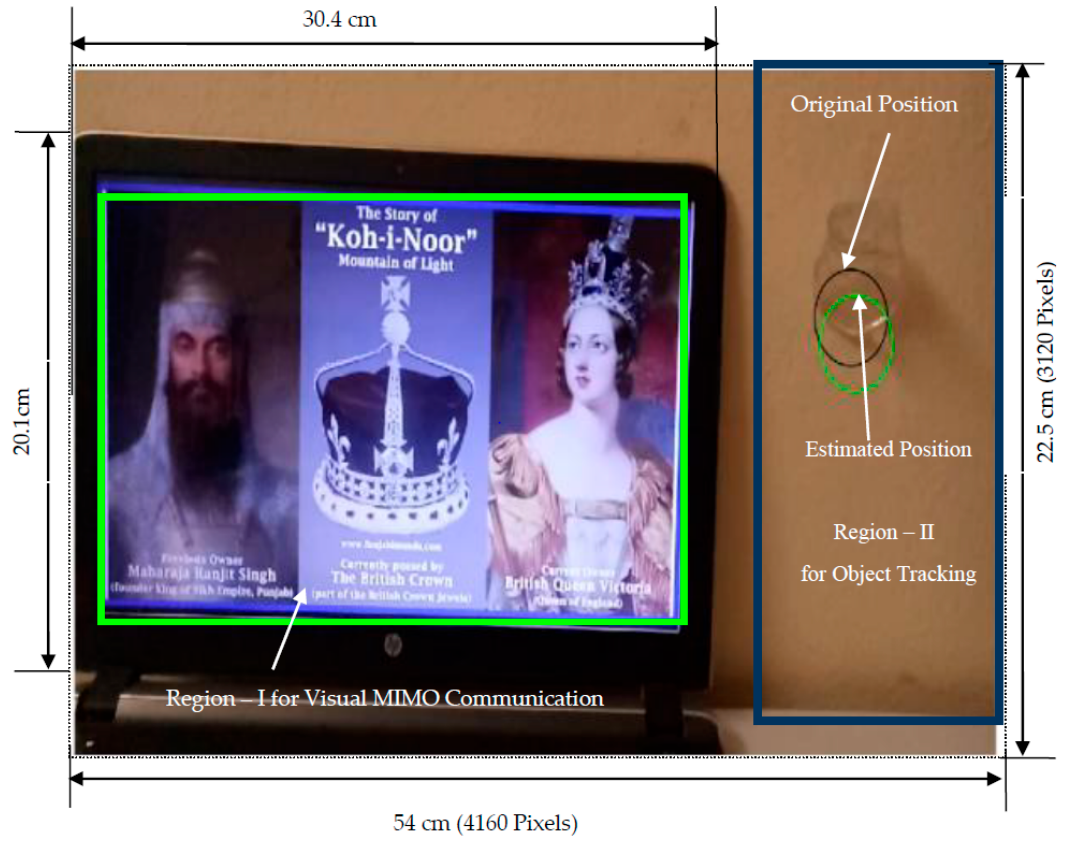
Figure 19. ROI for object tracking.